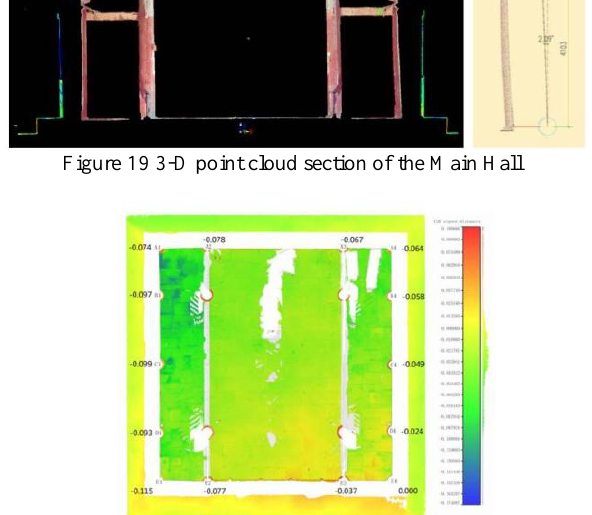
Figure 20 the Main Hall foundation and ground shape